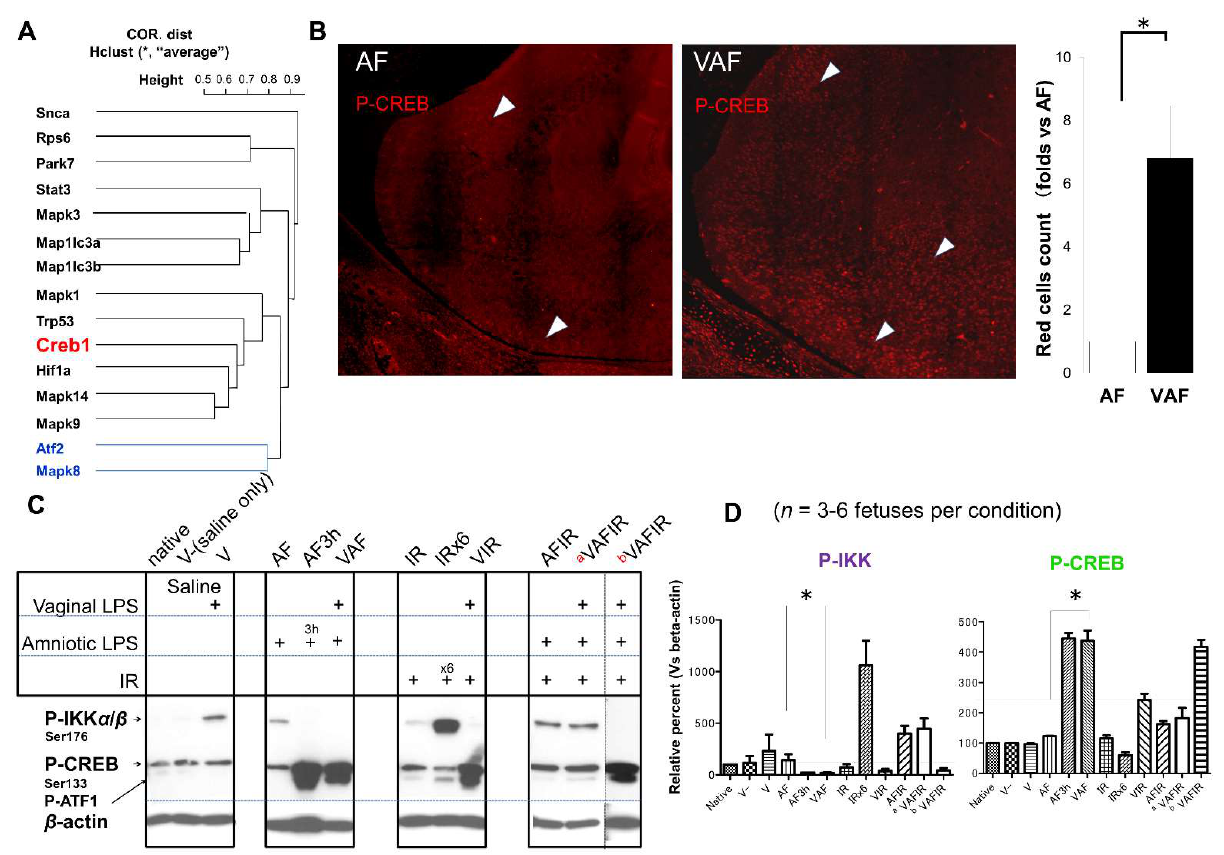
Figure 5. The phosphorylation of CREB was activated in VAF group but not in AF group. ( A ) hclust average of correlation distance of indicated proteins. ( B ) Immunochemistry images of phosphorylated CREB (ser133) in fetal brains derived from the amniotic LPS and VAF groups. * means p < 0.05. ( C , D ) Phosphorylated CREB and IKK were measured by western blotting. The bands under P-CREB are phosphorylation of ATF1. β-actin was used as a loading control. Samples from the VAFIR condition showed two distinct molecular phenotypes described as a VAFIR and b VAFIR respectively. * p < 0.05.